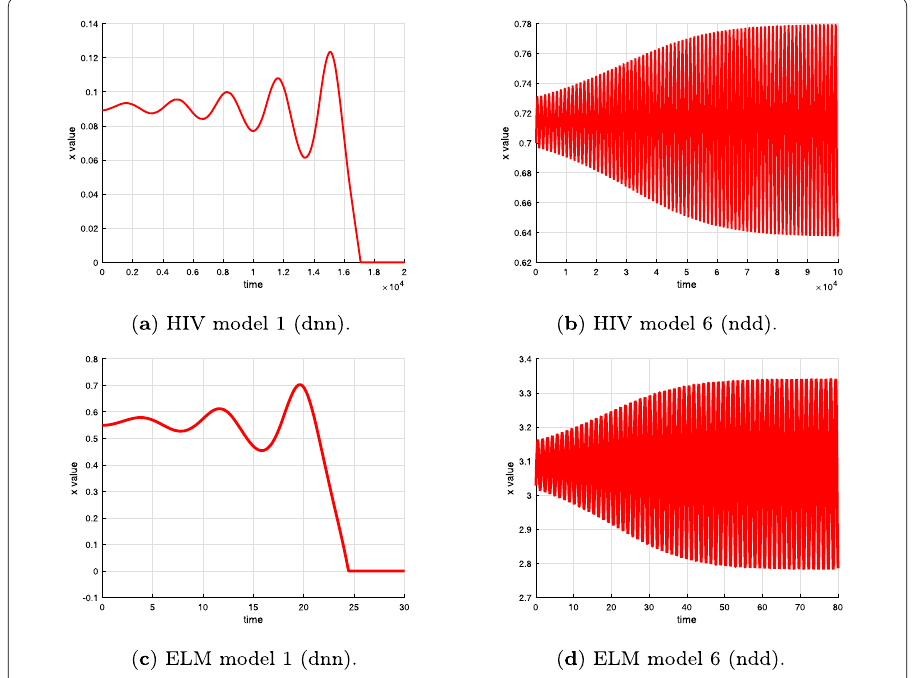
Figure 5 Solutions of HIV and ELM differential equations versions 1 and 6 for time delay greater than critical delay τ > τ c (see Table 11 and 12)